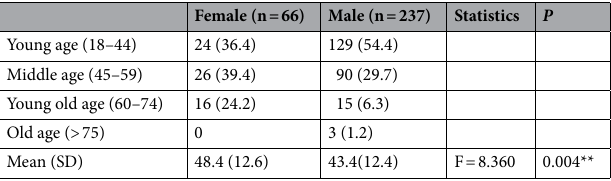
Table 1. The age distribution of all the patients in genders. ** P < 0.05.